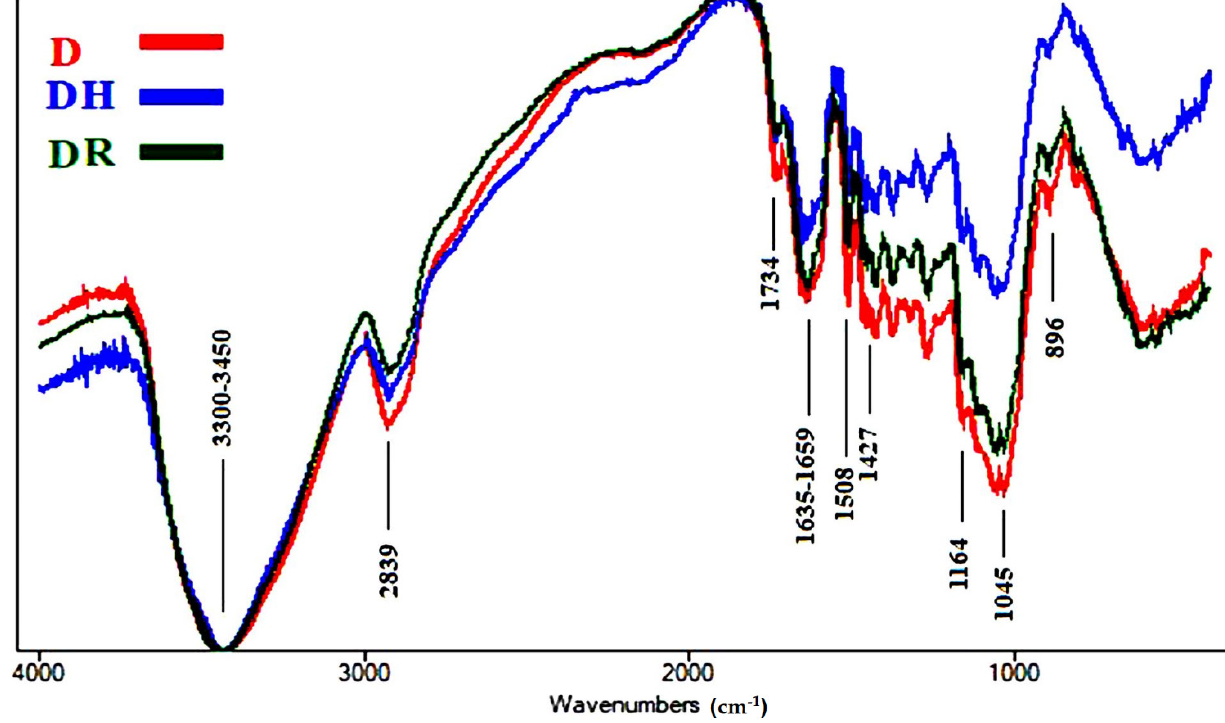
Figure 7. FTIR spectra of the wood samples of Pinus rigida (D, control; DH, heated ageing; DR, rusted ageing).